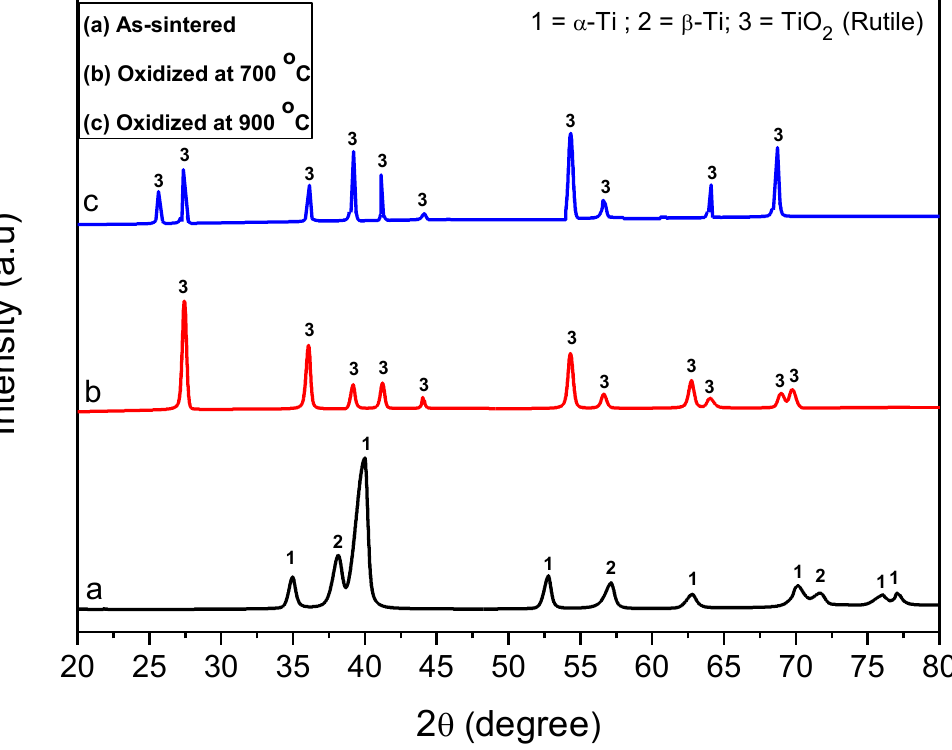
Figure 2. XRD patterns of Ti samples at different conditions: ( a ) as-sintered, ( b ) as- oxidized at 700 °C, and ( c ) as-oxidized at 900 °C.